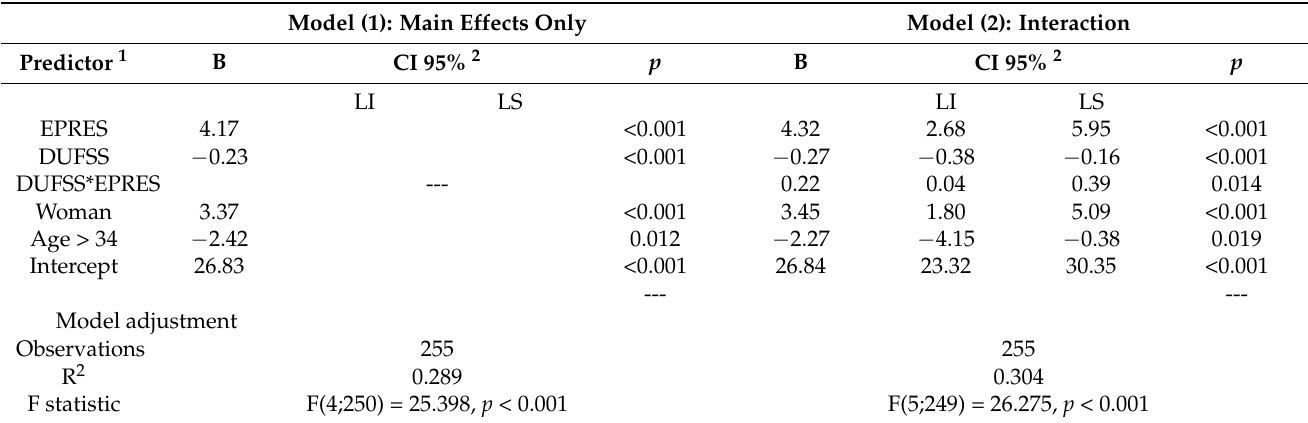
Table 2. Main effects (1) and interaction (2) regression results of social support and employment precariousness predicting perceived stress